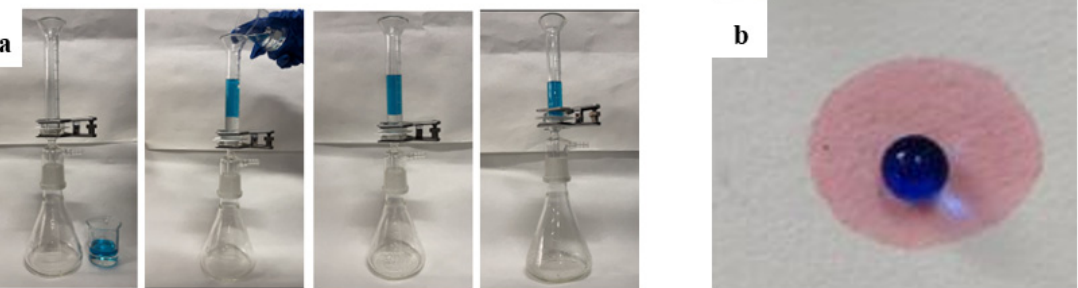
Figure 3. ( a ) Oil/water separation test using 20 mL mixture of carbon tetrachloride and water, and ( b ) mini-separation of a droplet of red-dyed carbon tetrachloride and a drop of blue-dyed water using the modified qualitative paper with slow filtering speed.